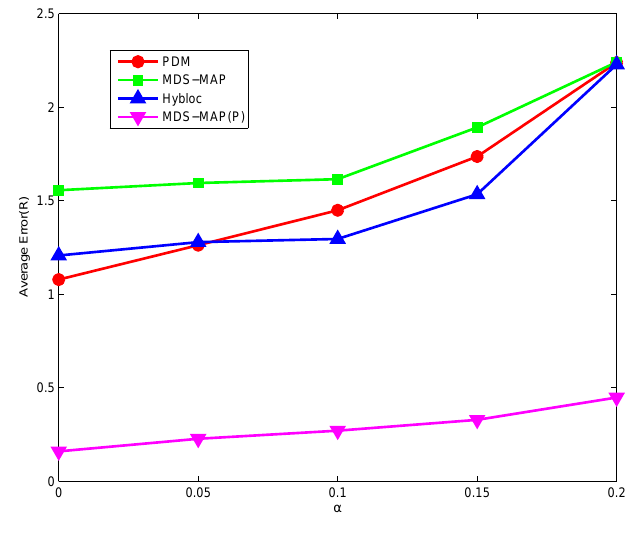
Figure 15 . 5 Clustered Anchors, Average Connectivity=18.61, C-shaped